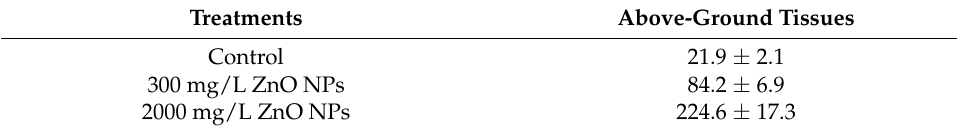
Table 1. The accumulation of Zn in above-ground tissues of H. sativum , mg/kg.